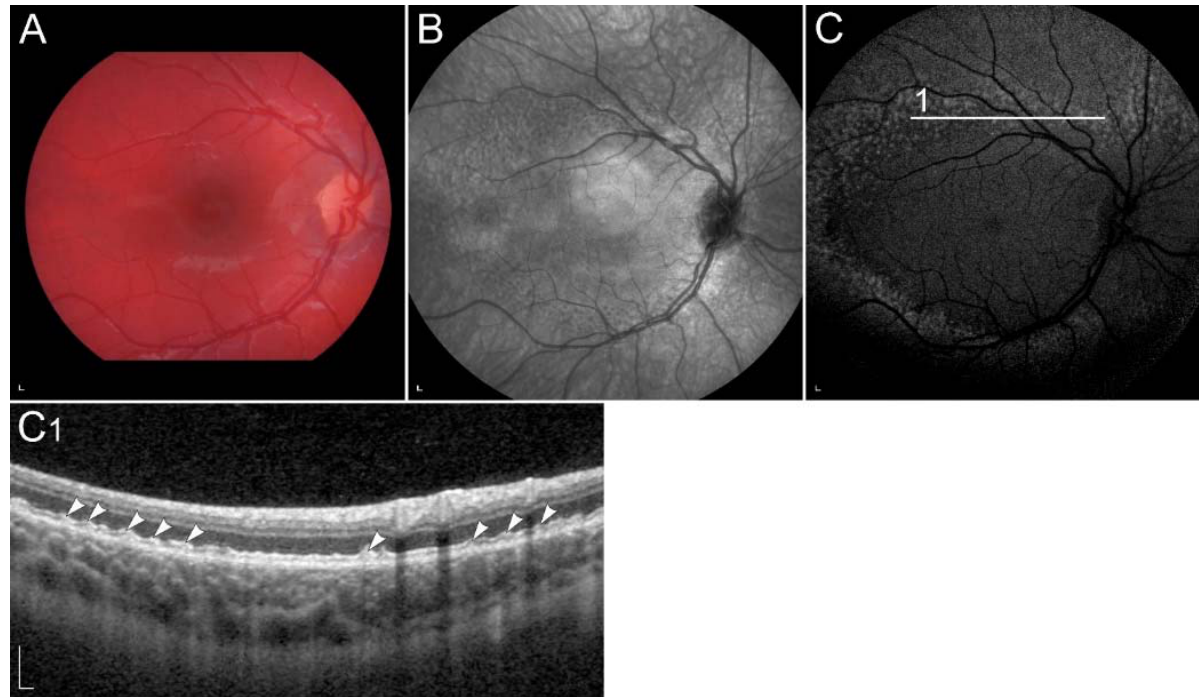
Figure 5. Clinical characteristics of a patient homozygous for p.(Thr137Ser) in RDH5 . ( A ) Colour fundus image, ( B ) infrared image and ( C ) FAF image with corresponding ( C1 ) SD-OCT image showing (arrowheads) retinal flecks. FAF image shows reduced autofluorescence in the entire retina. Patient’s best corrected Snellen decimal visual acuity was 0.8 on both eyes. Scale bars: 200 µ m. Source: Eye Hospital, University Medical Centre Ljubljana.